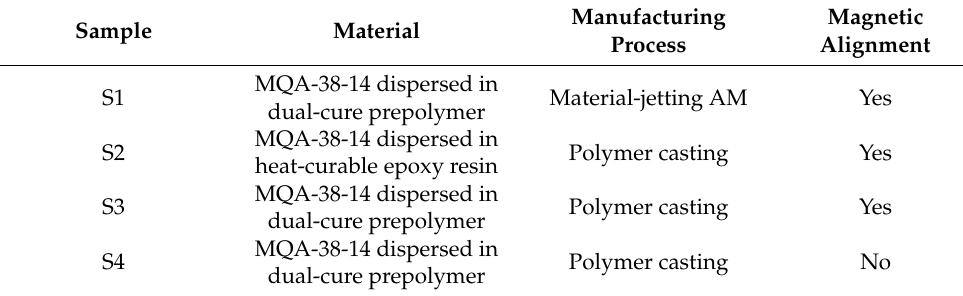
Table 1. List of fabricated and characterized sample types.